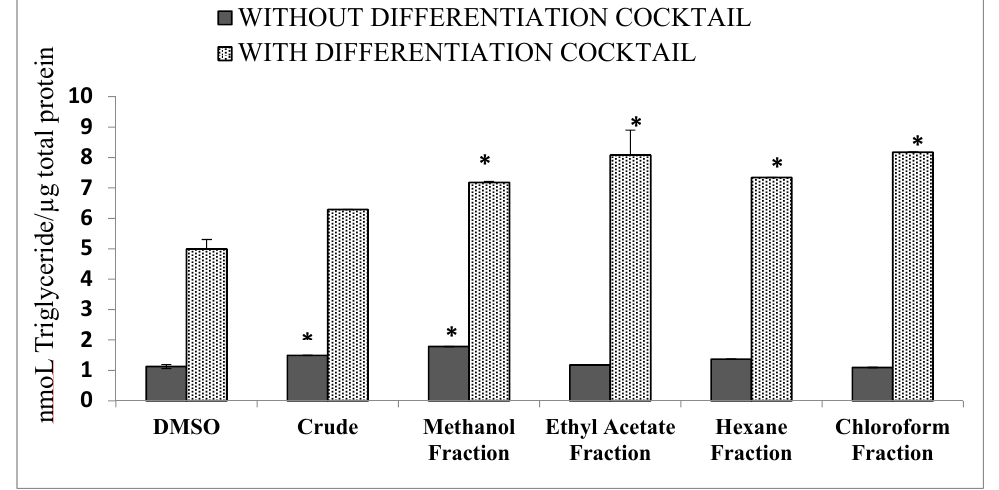
Figure 3. Effect of the crude aqueous extract and four fractions on 3T3L1 adipocyte differentiation with and without differentiation media. The quantification of intracellular triglycerides content and the total protein content is shown. Data were obtained from three independent experiments. The absorbance value is given as the mean ± SD. * p < 0.05. DMSO: dimethyl sulfoxide.